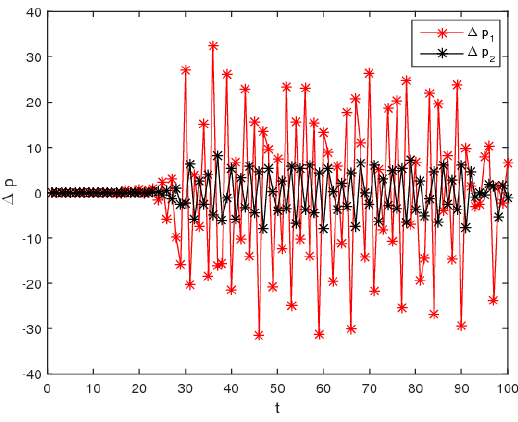
Figure 8. The sensitivity to initial value when ( p 1 , p 2 ) = (28, 20) and (28.001, 20).